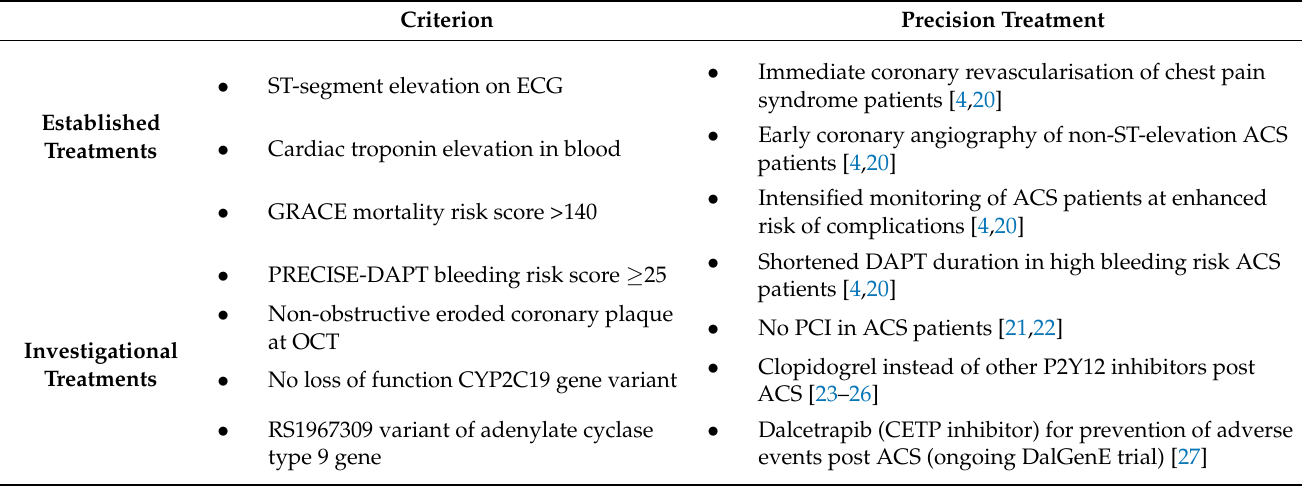
Table 2. Established and investigational precision treatments of